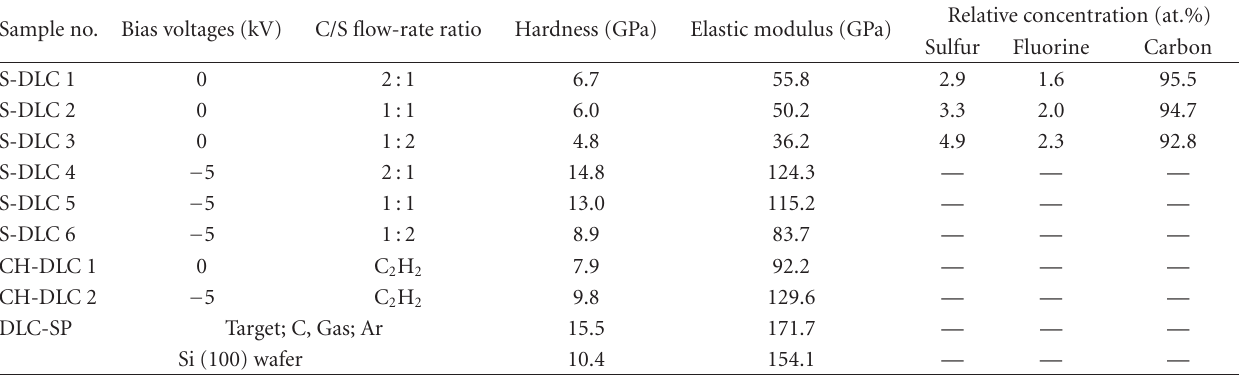
Table 2: Hardness, elastic modulus relative concentration values of all films as a function of bias voltages, C/S flow-rate ratios, and various methods.